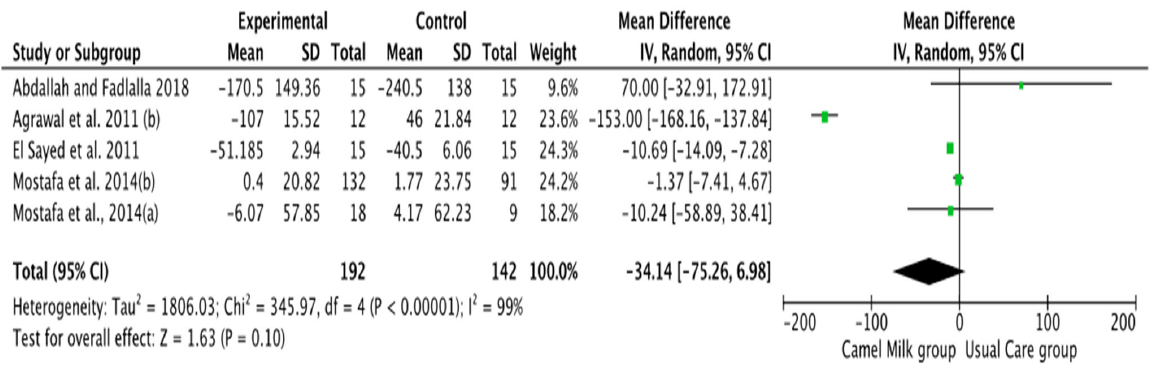
Figure 5. Forest plot for the effect of CM intake on postprandial blood glucose (PBG). Note: Mostafa and Al ‐ Musa, 2014 (a) for T1DM and (b) for T2DM.